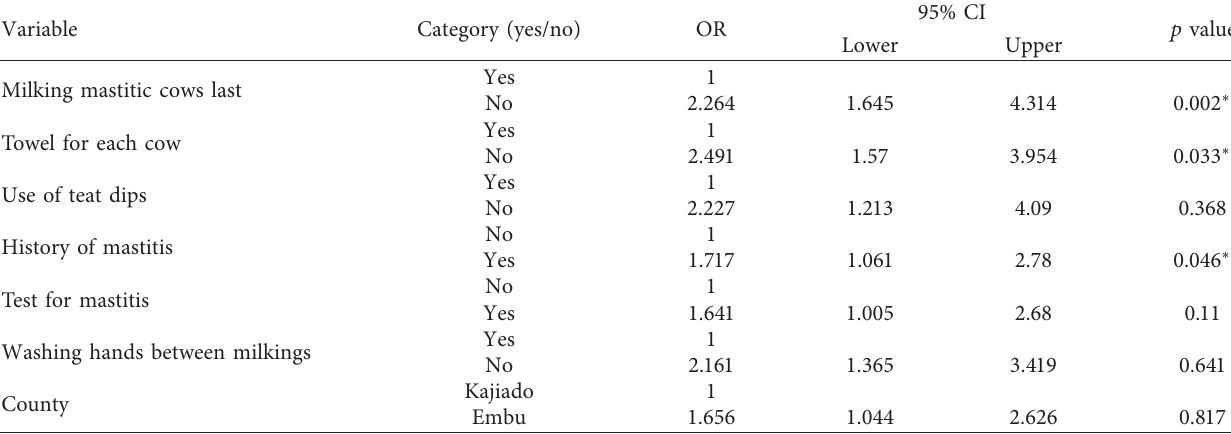
Table 5: Multivariable logistic regression analysis between different risk factors and cow-level mastitis (defined as culture positive) in 395 dairy cows in Embu and Kajiado